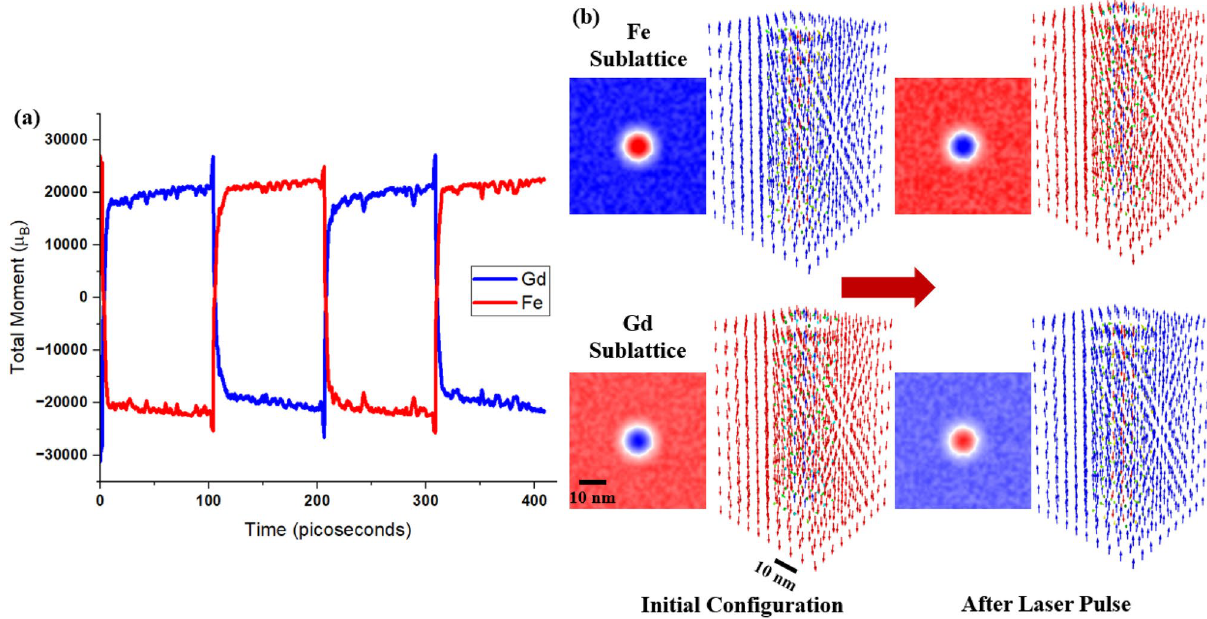
Figure 4. Ultrafast switching of a skyrmion in a synthetic antiferromagnet with bilayer FeGd. ( a ) Time evolution of magnetic moment after application of a 100-fs laser pulse with 30 J/m representation of spins in Fe and Gd sublattice before and after switching by laser pulse. Inserted figures indicate the top-view of the color mapping of out-of-plane reduced magnetic moments (m z ) in both Fe and Gd sublattices, before and after switching by laser pulse. Red colors represent down magnetic moments, blue colors represents up magnetic moments, and white colors represent in-plane magnetic moments. Both layer of FeGd are shown here, where the top half of each schematic correponds to the top FeGd layer and the bottom half corresponds to the bottom FeGd